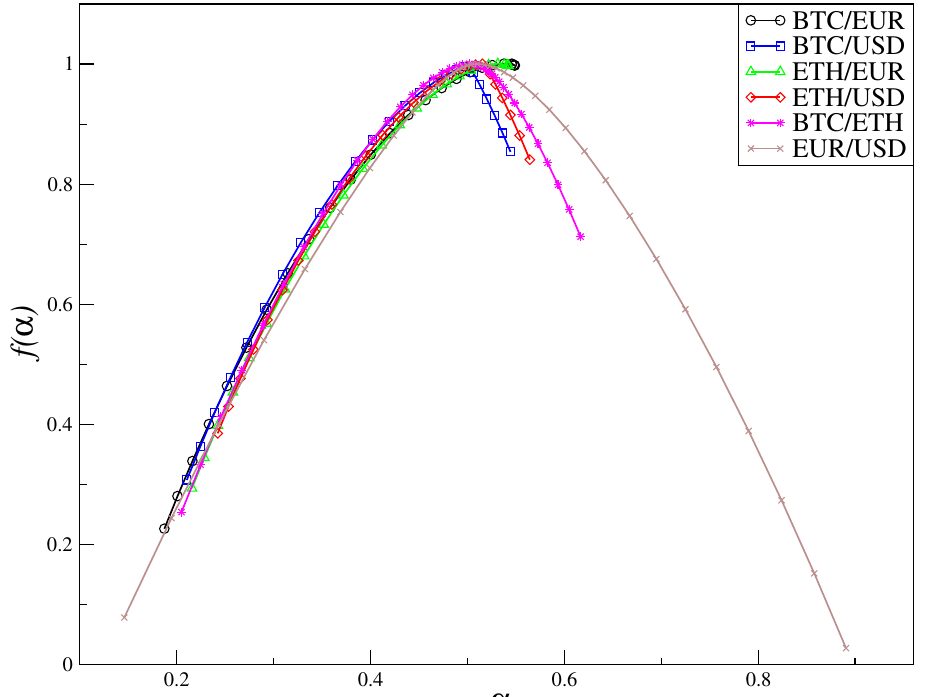
Figure 6. (Color online) Singularity spectra f ( α ) calculated for all six considered time-series of BTC/EUR, BTC/USD, ETH/EUR, ETH/USD, BTC/ETH and EUR/USD returns, setting q ∈ [ − 4,4 ] . Insets show the q -dependence of the corresponding generalized Hurst exponents h ( q )